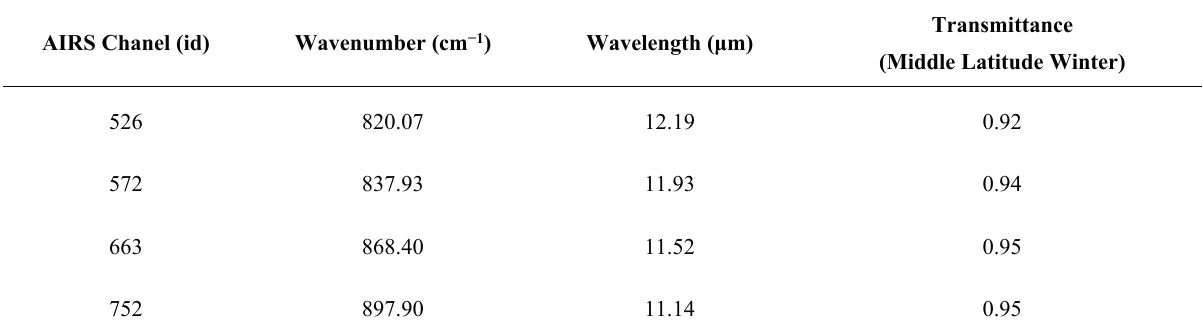
Table 2. AIRS selected channels ID, wavenumber, wavelength, and channel